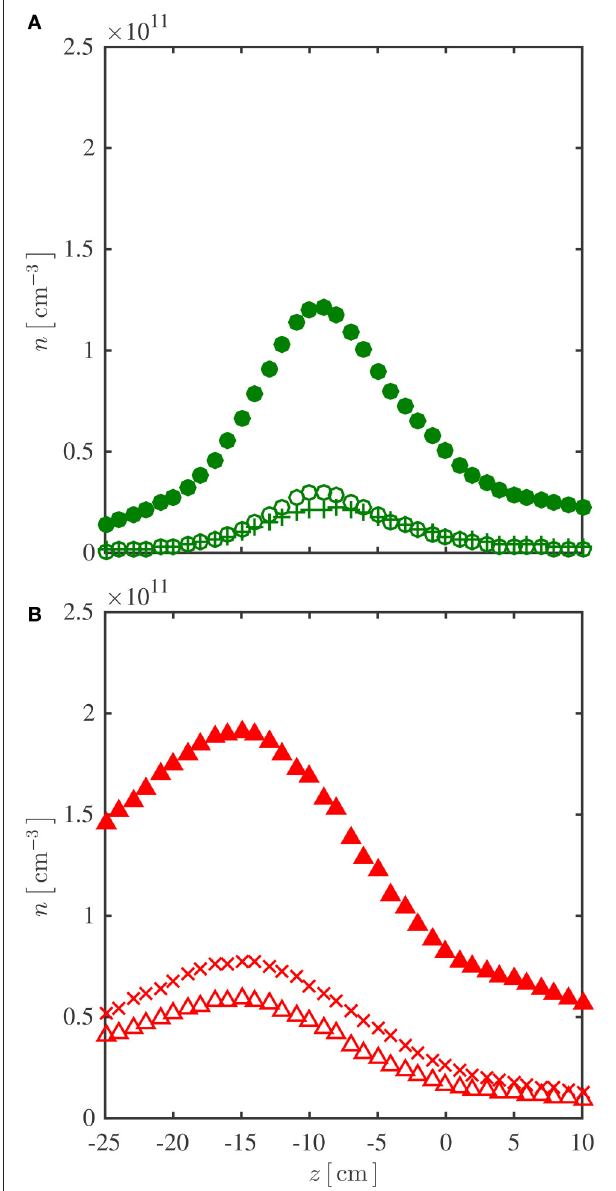
FIGURE 4 | (A) High field mode, on-axis profiles of LP-measured ion density n i obtained from Sheridan’s method [Equations (2) and (3), open circles], and from the simplified method [Equation (1), solid circles], and CP-measured electron density n e from the Druyvesteyn theory [Equation (5), pluses]. (B) Low field mode, on-axis profiles of ion density obtained from Sheridan’s method (open triangles) and from the simplified method (solid triangles), and electron density from the Druyvesteyn theory (crosses).